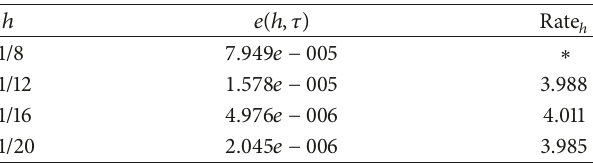
Table 2: Maximum errors and convergence order in spatial direc- tion with 𝜏 = 1/2000 and 𝛼 = 0.2 for Example